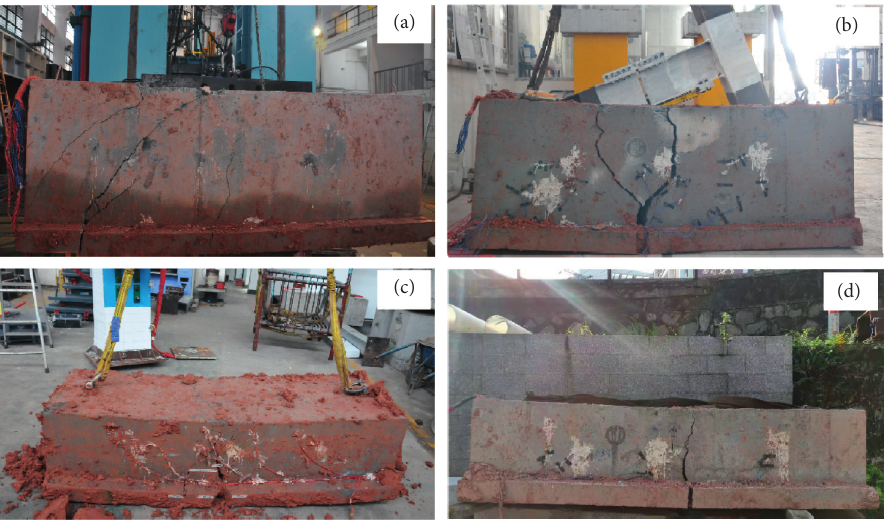
Figure 8: Damage patterns: (a) for A1, (b) for A2, (c) for B1, and (d) for